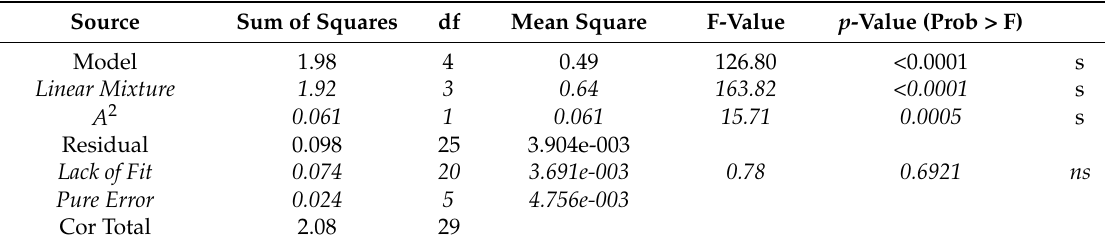
Table 5. Analysis of variance table for particle size (Poly- ɛ -caprolactone-based nanoparticles. Source